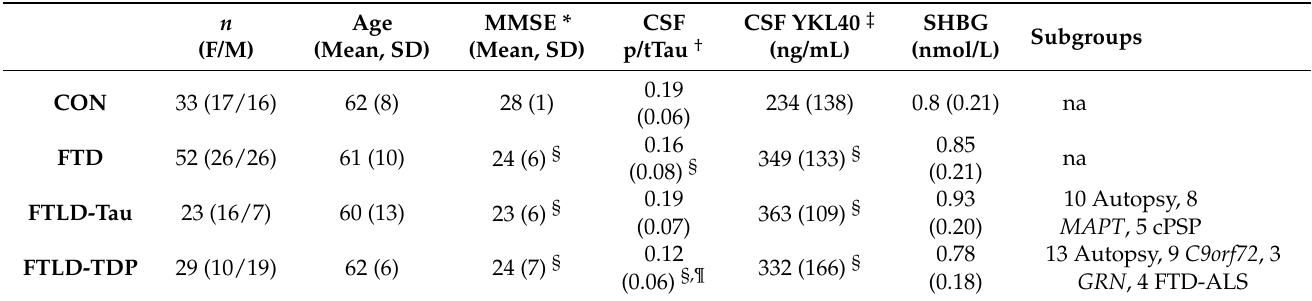
Table 1. Demographic